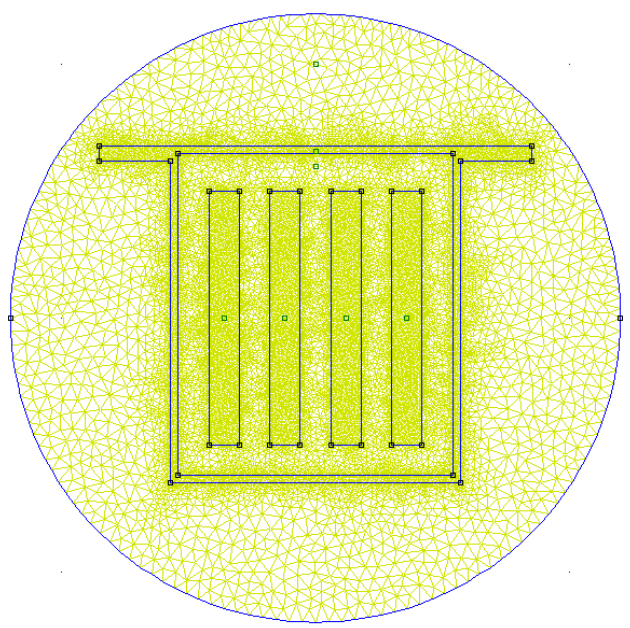
Energies 2019 , 12 , 1419 Figure 16. The cross-section of busbar system (shielded)with finite element method (FEM) mesh.